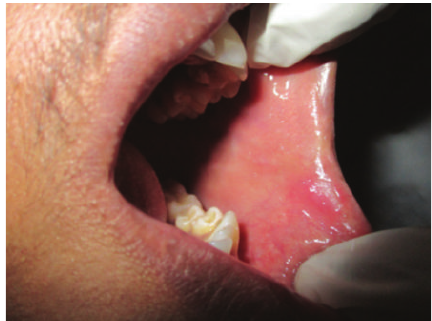
Figure 5: Healed ulcers on left commissure of buccal mucosa.